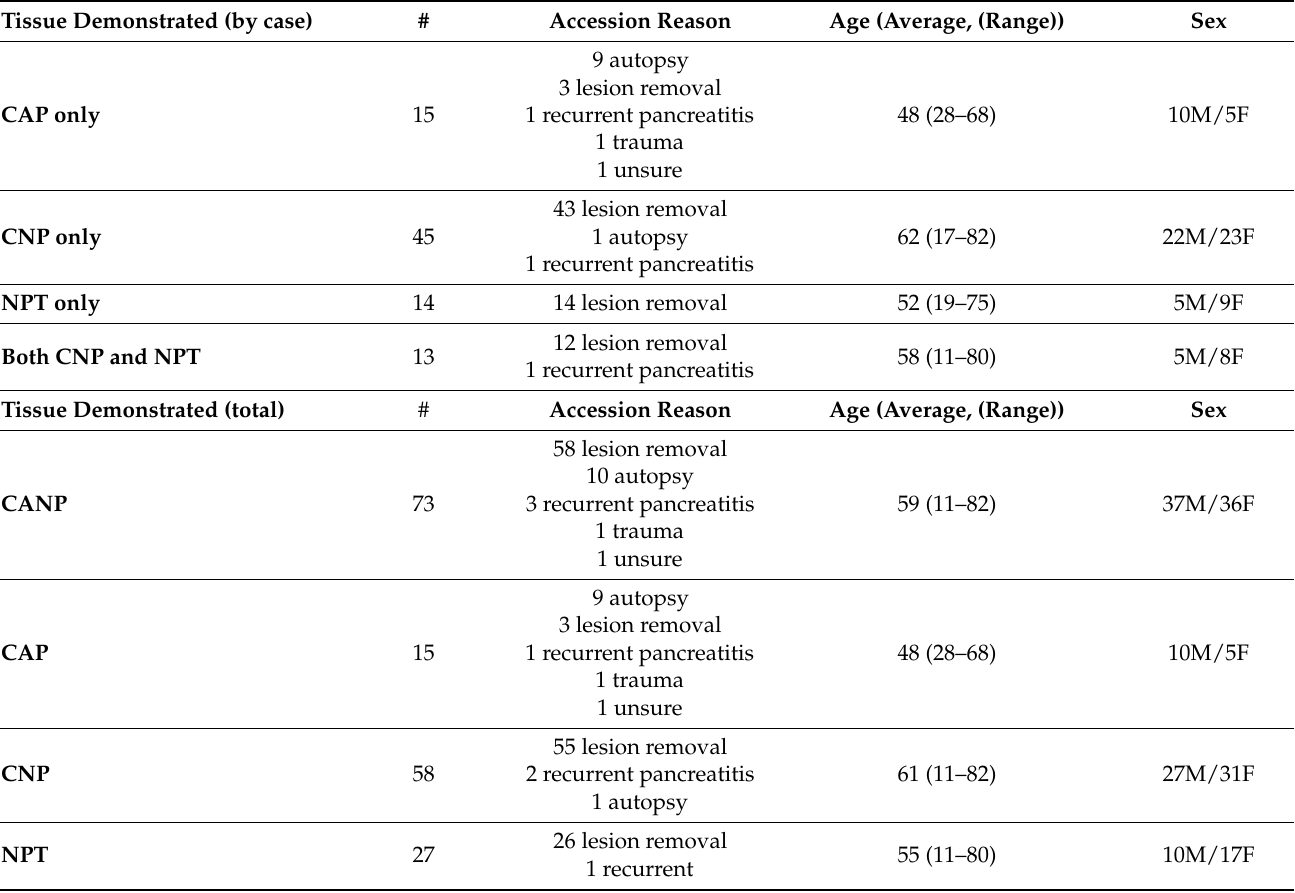
Table 2. Study cohort. CANP, chronic alcoholic and non-alcoholic pancreatitis; CAP, chronic al- coholic pancreatitis; CNP, chronic non-alcoholic pancreatitis; F, female; M, male; NPT, normal pancreatic tissue.